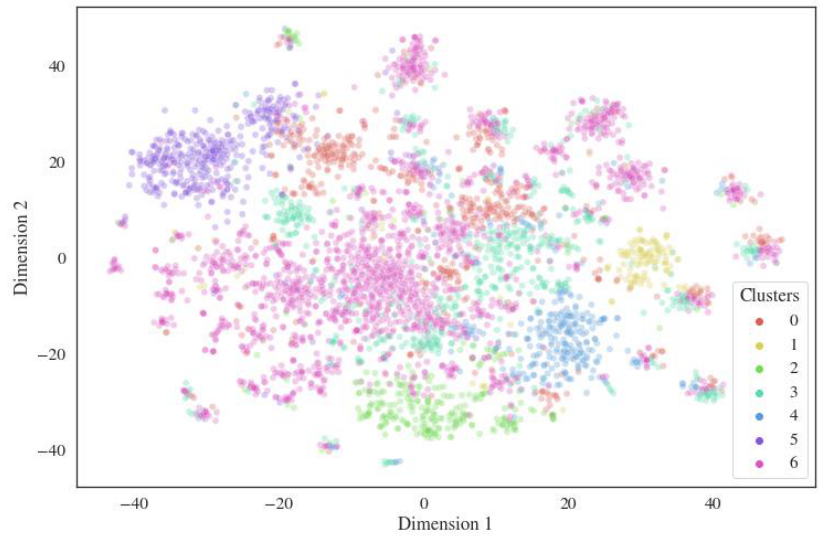
Figure 2. Main clusters identified by K-Means clustering.